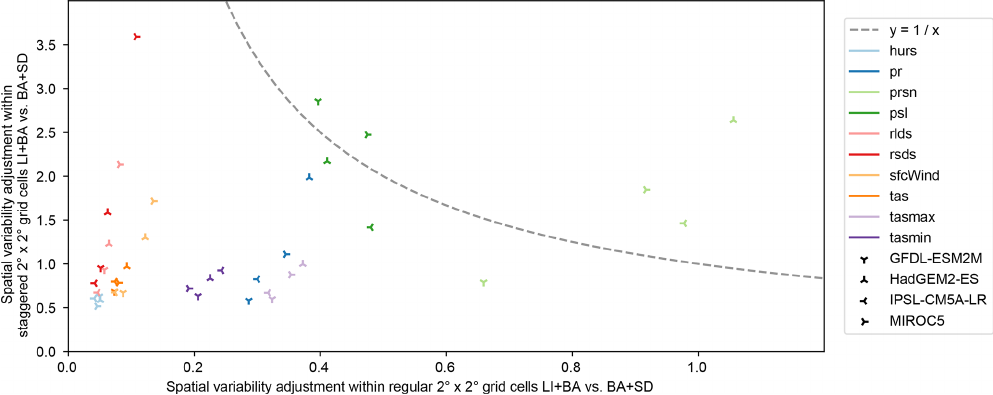
Figure 10. Goodness of adjustment of spatial variability within regular ( x axis) and staggered ( y axis) 2 ◦ × 2 ◦ grid cells by the LI + BA and BA + SD bias adjustment and statistical downscaling methods for 10 different climate variables (color, Table 1) simulated by four different climate models (symbols). Values on both axes represent ratios of spatiotemporally aggregated absolute errors after bias adjustment and statistical downscaling with the two methods (see Sect. 3.3). Values greater than 1 indicate better spatial variability adjustment by LI + BA than by BA + SD and vice versa for values smaller than